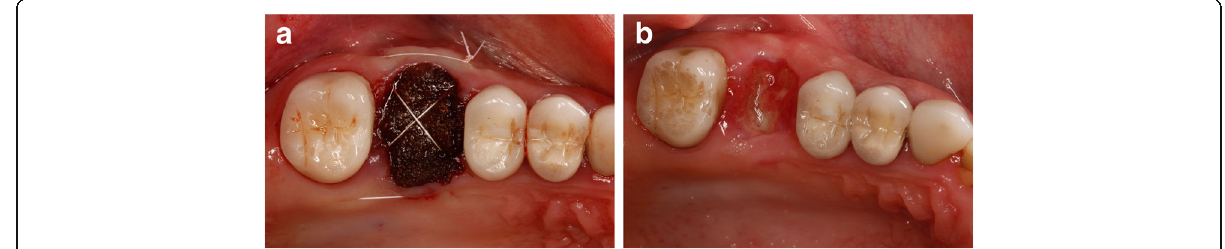
Fig. 11 a Healing after closure by oxidized cellulose. b Healing after 14